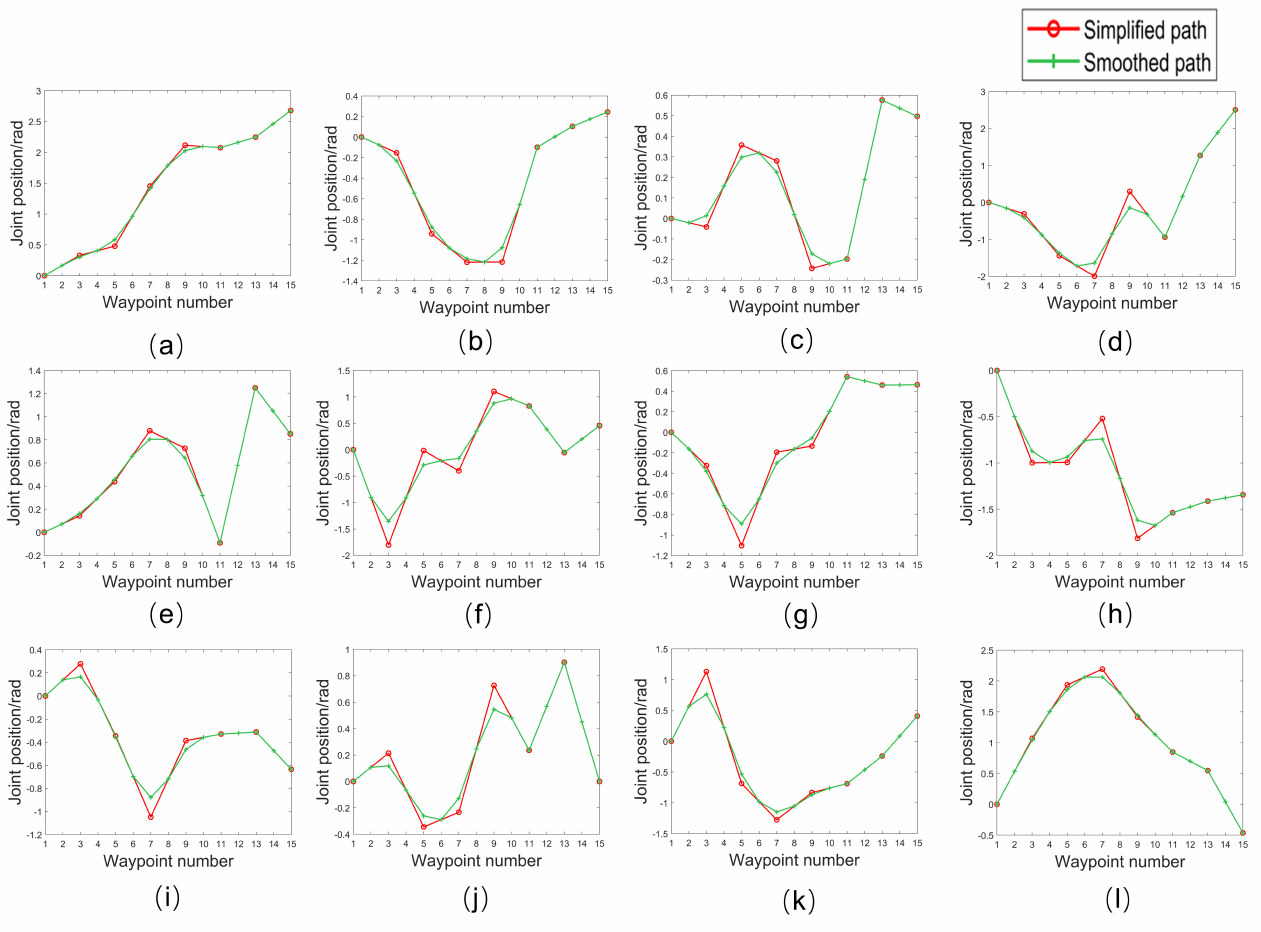
Figure 10. Comparison of simplified path and smoothed path of each joint. ( a – f ) Positions of the left robot joint 1–6. ( g – l ) Positions of the right robot joint